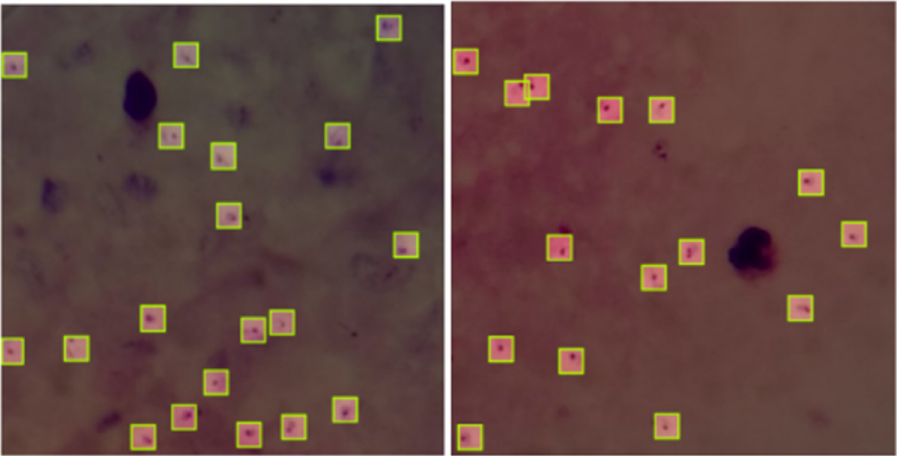
Figure 3. P . falciparum annotated dataset with highlighted malaria parasites and